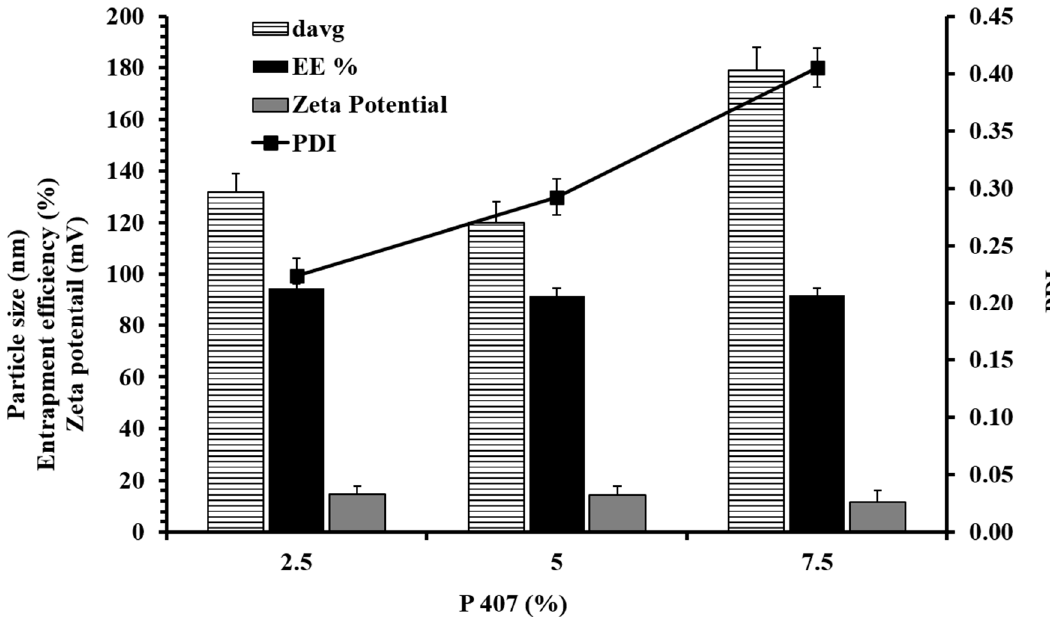
Figure 1. Effect of surfactant concentration on particle characteristics (d-avg, PDI, zeta potential) and percentage of entrapment efficiency (% EE).